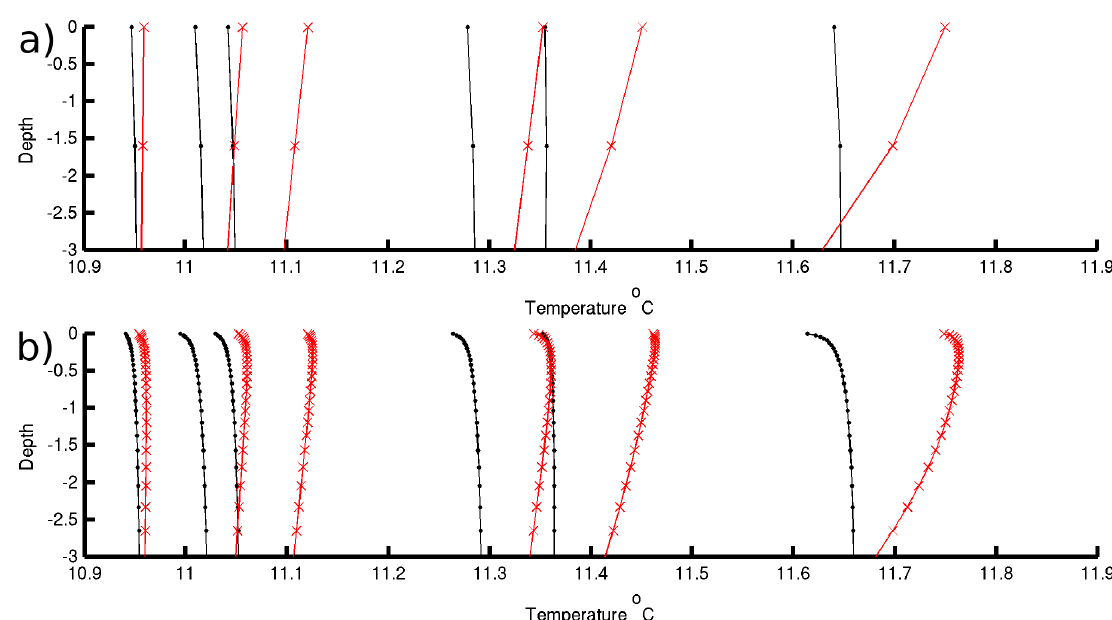
Figure 8. Examples of near-surface profiles of temperature for days 18–20 May 2009 for Experiment ( a ) A and ( b ) B. During those days, average night–day temperature differences were of the order of 0.5 ◦ C. Wind speed averaged 9 ms − 1 . Black lines represents night time profiles (03 and 21 h) while red lines represent day time profiles (09 and 15